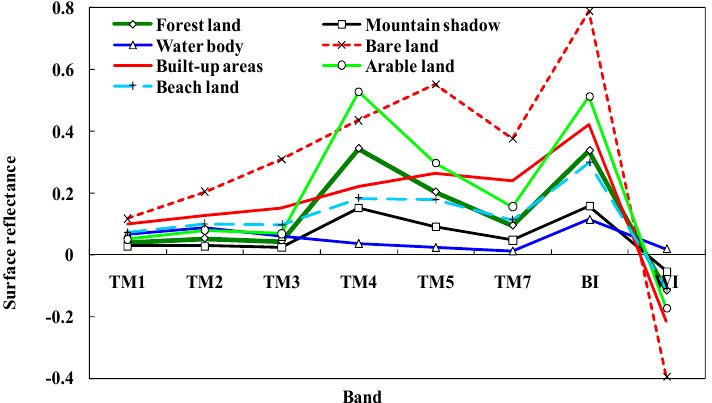
Figure 5. Spectral profiles of typical land use and land cover types in the study area in 2007. Beaches are one of the most important land-use types in coastal cities, but it is difficult to separate beaches from built-up land because of their similar spectral characteristics. The wetness index (WI), the third tasseled-cap band, is typically used as an index of “wetness” (e.g., soil or surface moisture). Compared with the spectral characteristics of built-up land, beaches have a high WI and low terrain. Thus, they can be distinguished from built-up land by combining image analysis with elevation information. Tasseled cap transformation reflectance coefficients for TM and OLI images were cited from Crist [42] and Baig et al. [43], respectively: